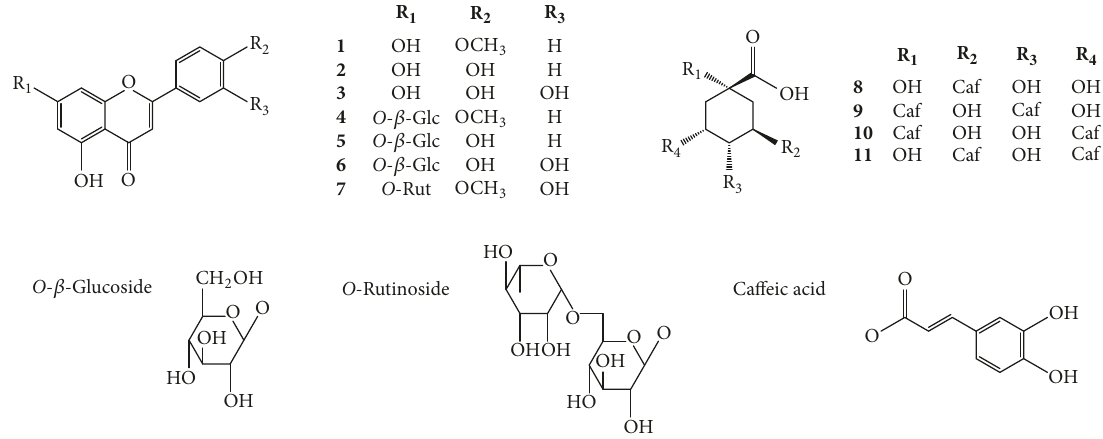
Figure 2: Chemical structures of compounds found in ADC flowers.